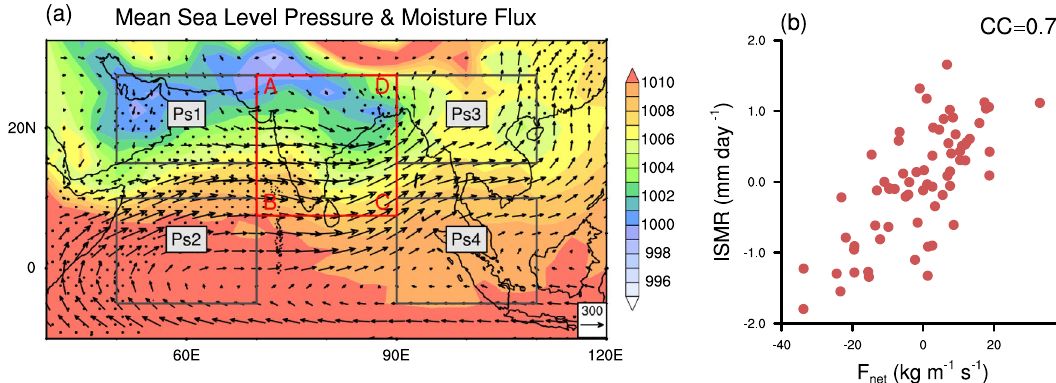
Figure 1. ( a ) Boreal summer season (June–September) climatological mean sea level pressure (MSLP) in hPa, 1 s − 1 along with vertically integrated moisture flux vectors ( kgm − ) during the 1948-2015 period. The box ABCD represents the study region (7.5 ◦ –27.5 ◦ N, 70 ◦ –90 ◦ E). The surrounding boxes represent the regions of surface pressure used for determining the incoming and outgoing moisture fluxes ( Ps1 : 15 ◦ –27.5 ◦ N, 50 ◦ –70 ◦ E, Ps2 : 5 ◦ S–10 ◦ N, 50 ◦ –70 ◦ E, Ps3 : 15 ◦ –27.5 ◦ N, 90 ◦ –110 ◦ E, Ps4 : 5 ◦ S–10 ◦ N, 90 ◦ –110 ◦ E). ( b ) The scatter of Indian summer monsoon rainfall (ISMR, only land points of region ABCD) versus net moisture convergence ( F net ) over the entire region marked by ABCD. Inset value is for correlation coefficient (CC) between ISMR and F net for 1948- 2015. The dotted regions in Fig. 1a indicate a correlation coefficient between ISMR and F net , which is significant at a 90% confidence level (using t-test). This figure was created using NCL version 6.4.0 (https:// www. ncl. ucar.